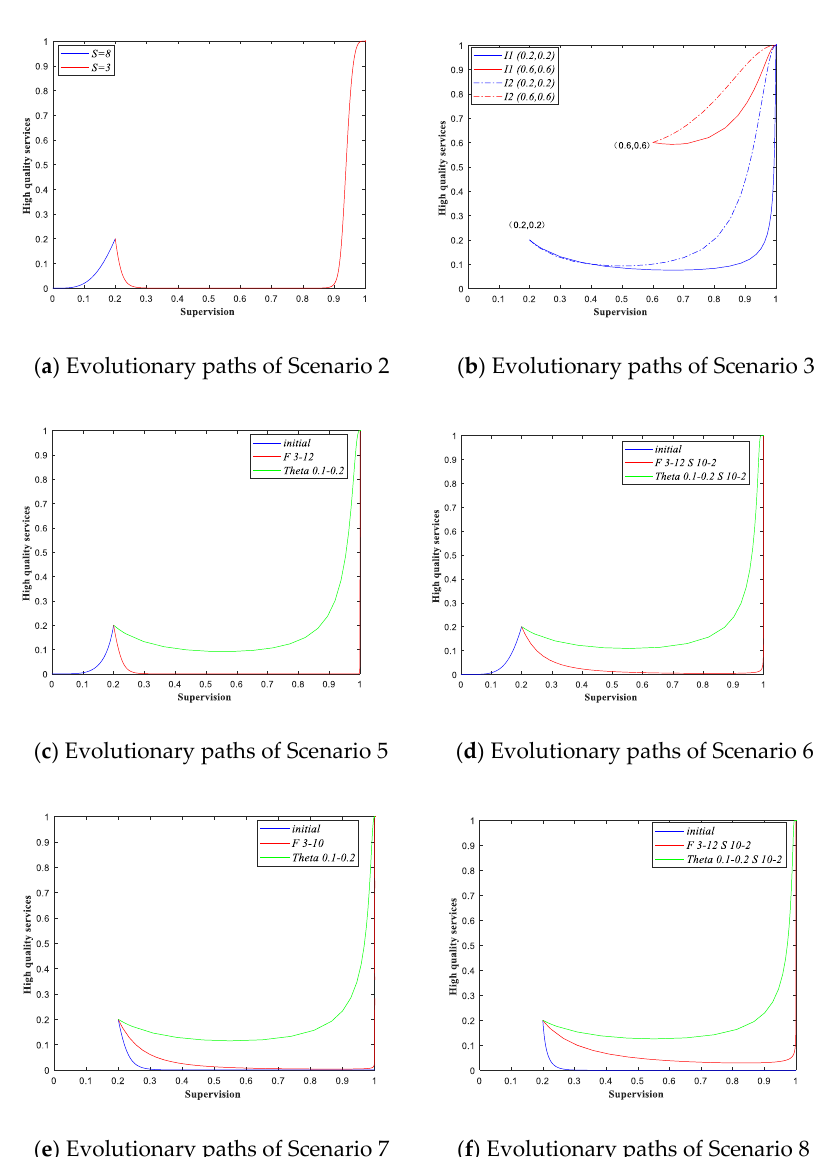
Figure A2. The evolutionary paths of the system in different scenarios.